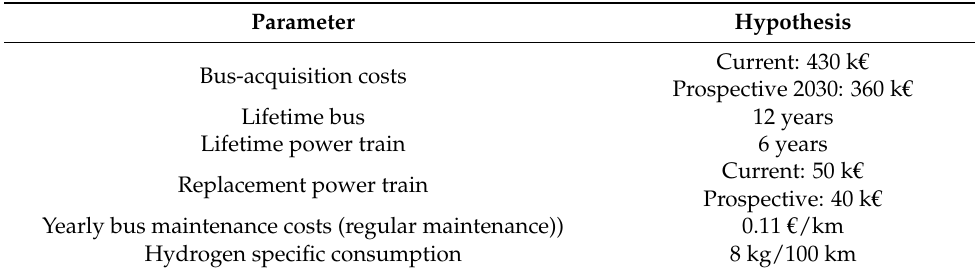
Table 8. Parameters set for TCO calculation—hydrogen